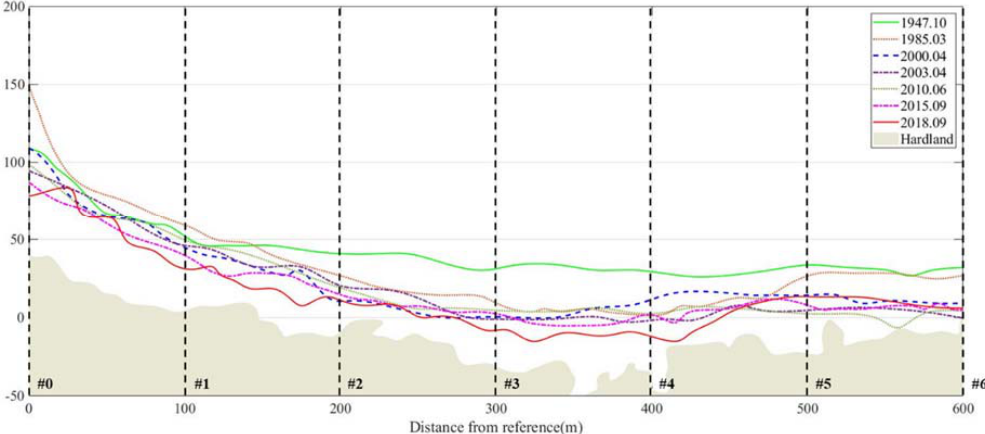
Figure 15. Shoreline data from overlay analysis in Janghang Beach.